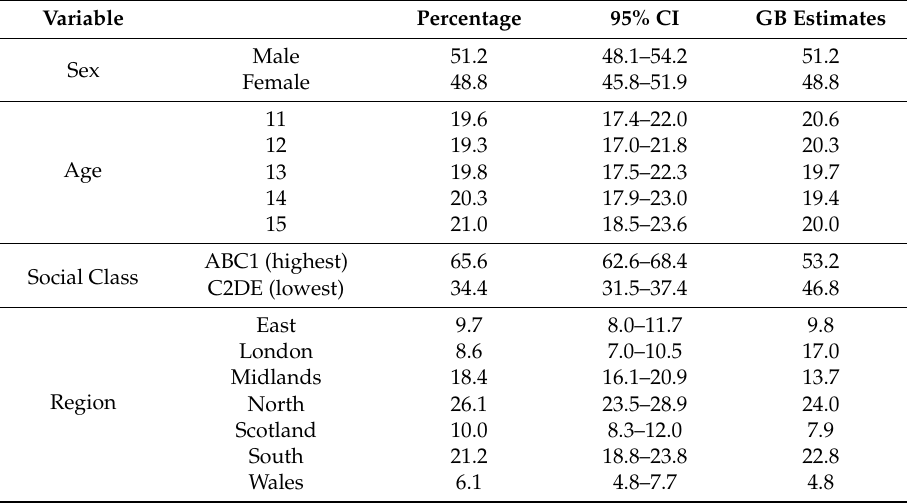
Table 4. Descriptive statistics of youth